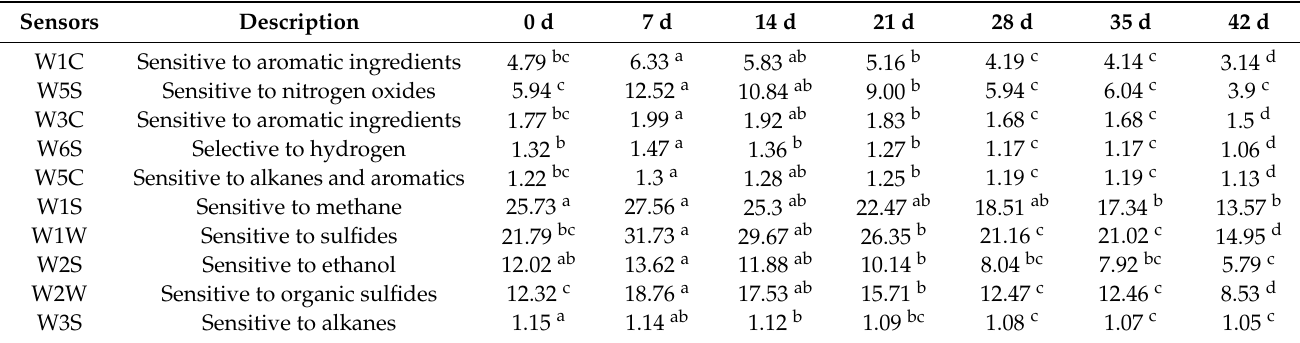
Table 1. Aroma values of E-nose at different fermentation